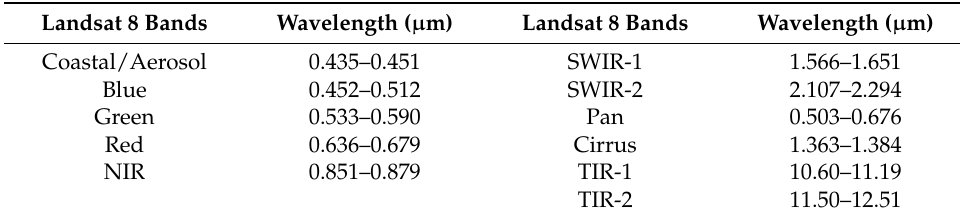
Table 2. Landsat 8 wavelength characteristics.